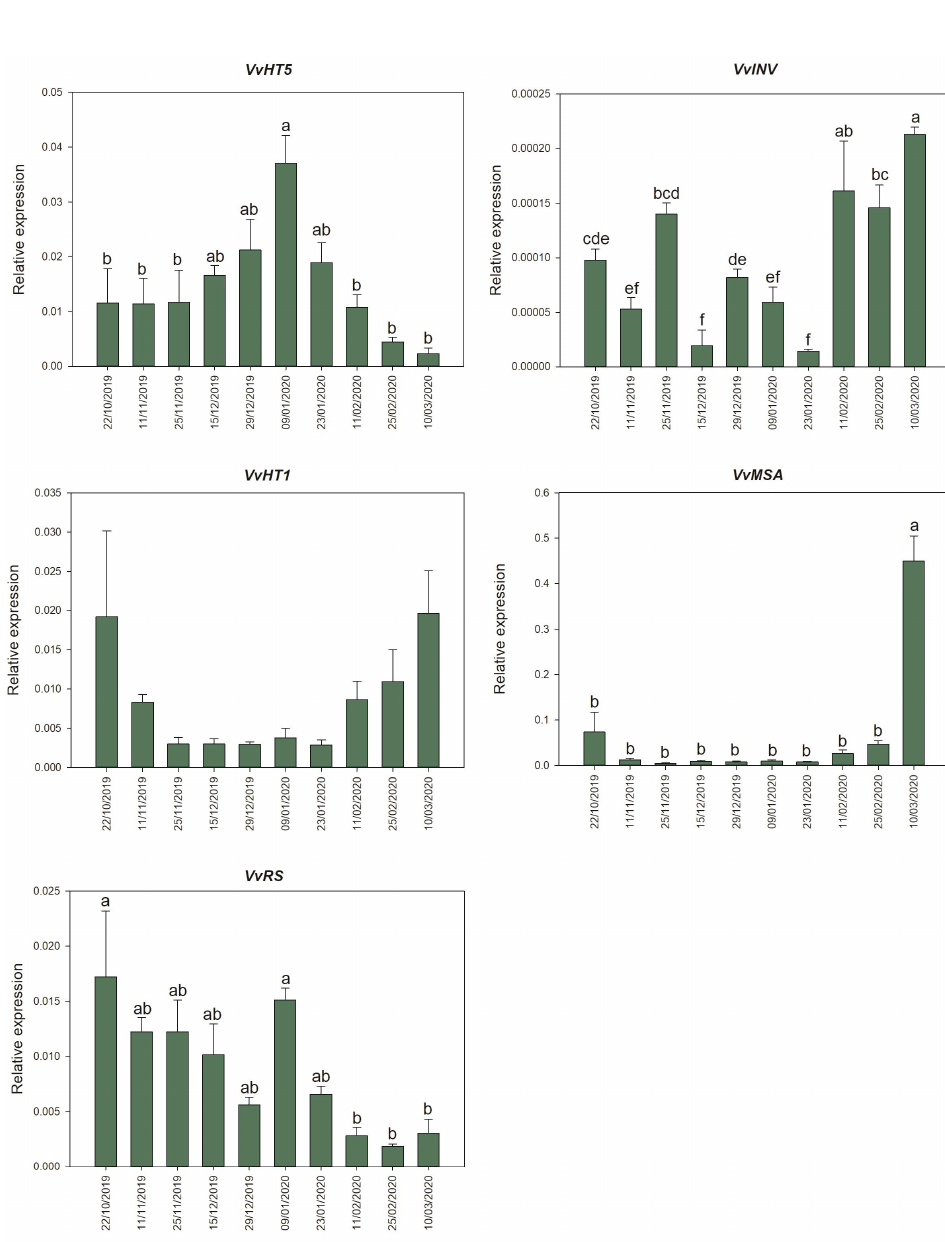
Figure 3. qPCR analysis of buds of hybrids UD 31-103 throughout the 2019/2020 winter season. Results are expressed as the mean of 3 biological replicates of 10 buds ± standard error. VvHT5 = Hex- ose Transporter 5; VvHT1 = Hexose Transporter 1; VvINV = Cell Wall Invertase; VvMSA = Maturation, Stress, ABA; VvRS = raffinose synthase. Letters represent the results of statistical analyses; in the VvHT1 expression pattern, no significant difference was